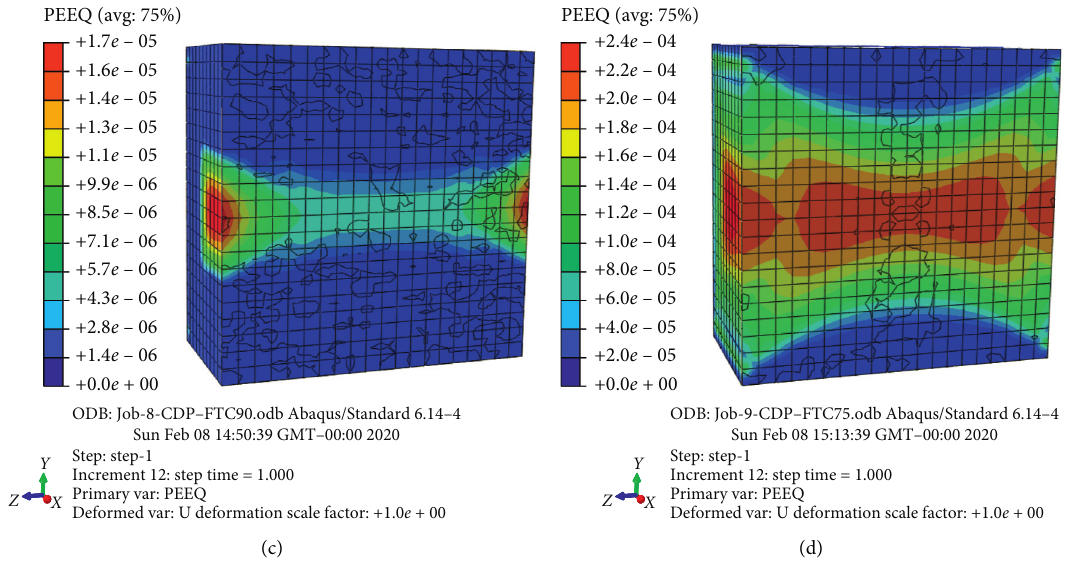
Figure 7: Equivalent plastic strain nephogram for freeze-thaw concrete: (a) FTC00; (b) FTC25; (c) FTC50; (d)